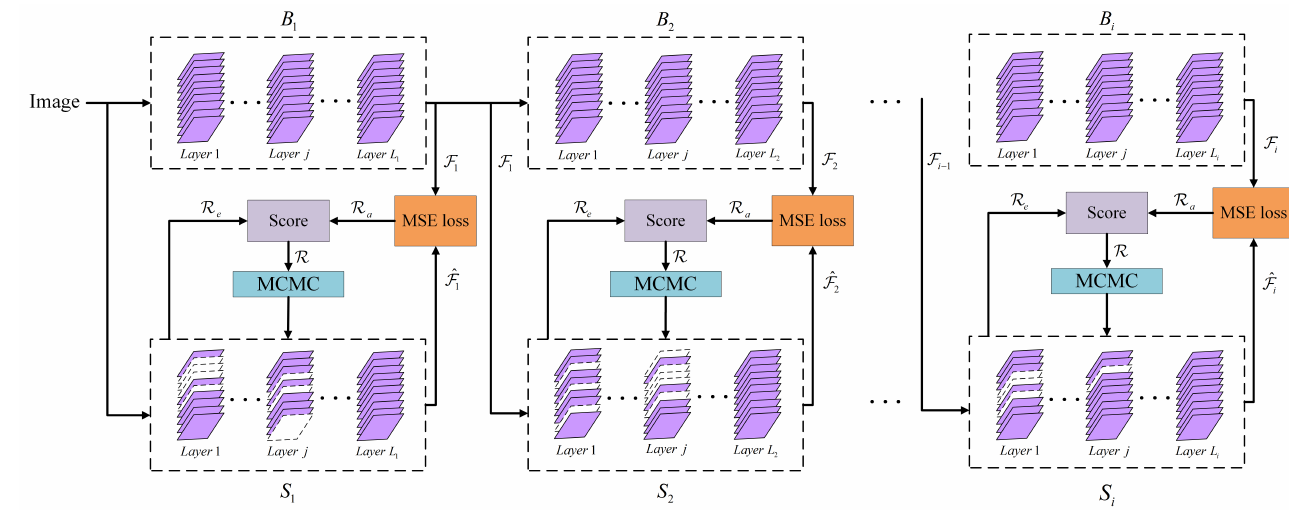
Figure 1. Illustration of our BNP. Network pruning is decomposed into block-wise shrinkage based on knowledge distillation. The blocks at the top form teacher network, and the blocks at the bottom constitute student network. Each student block is independently compressed to imitate the behavior of the corresponding teacher block by minimizing the MSE loss between output feature maps. Markov Chain Monte Carlo is used to sample substructures for evaluation by scoring each substructure with accuracy metric R a and efficiency metric R e